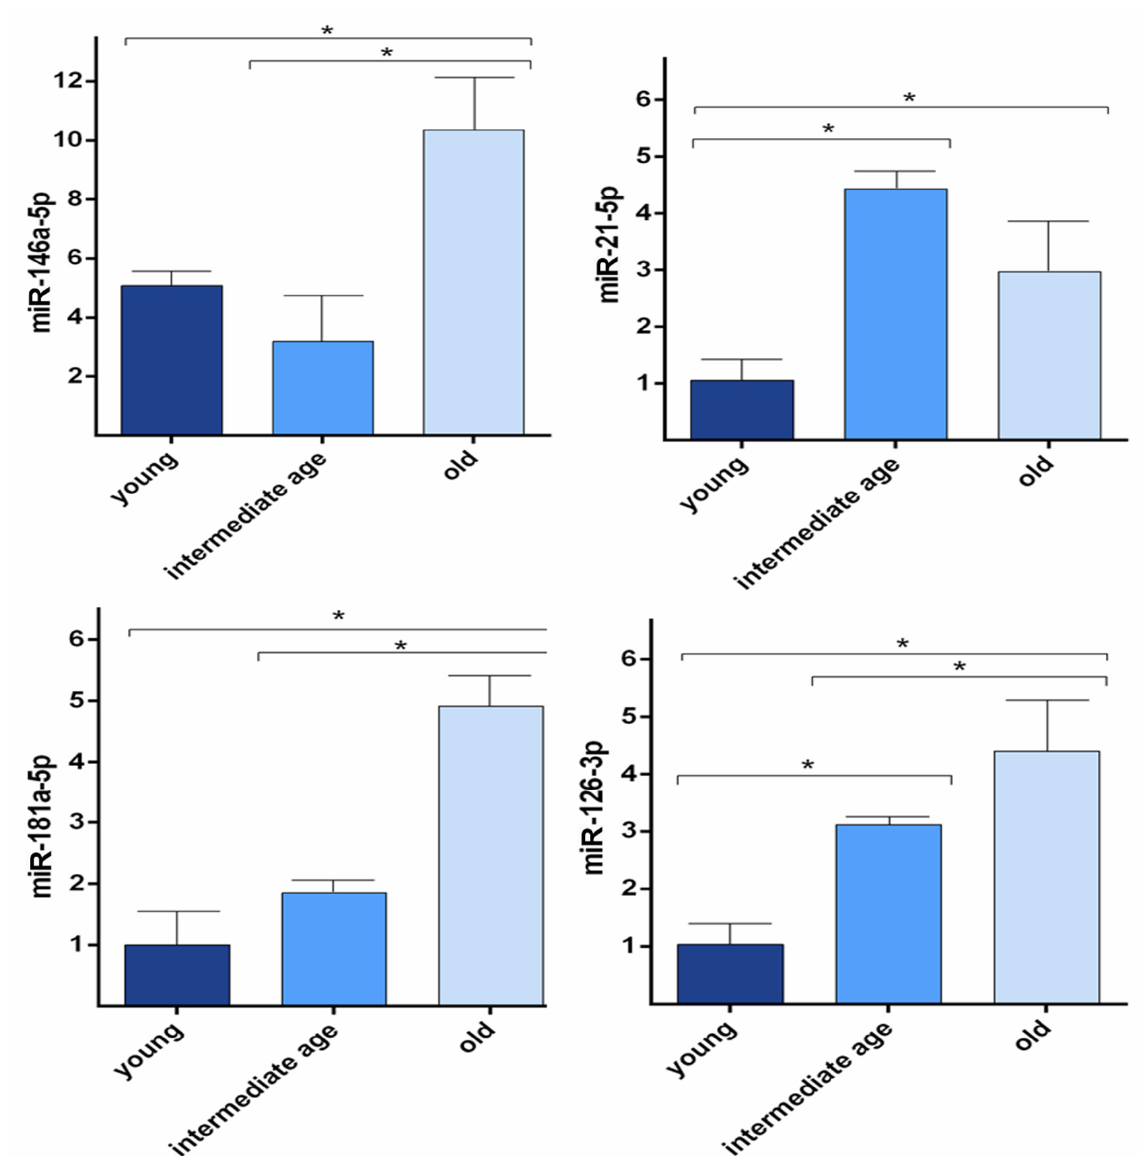
Figure 3. miRNAs levels variation in HUVECs undergoing senescence. Bar charts show extracellular miR-146a-5p, miR-21-5p, miR-181a-5p, miR-126-3p levels in young, intermediate, and old (senescent) HUVECs. Data were calculated by qRT-PCR and represent mean ± SD of three different experiments analysed. CTs (cycle thresholds) resulting from qRT-PCR analysis were normalised with miR-30a; levels were calculated with 2-DCT method and expressed as folds, with respect to lowest value registered. Comparisons among multiple groups were analysed by one-way analysis of variance, followed by Bonferroni’s post hoc test. * p < 0.05.